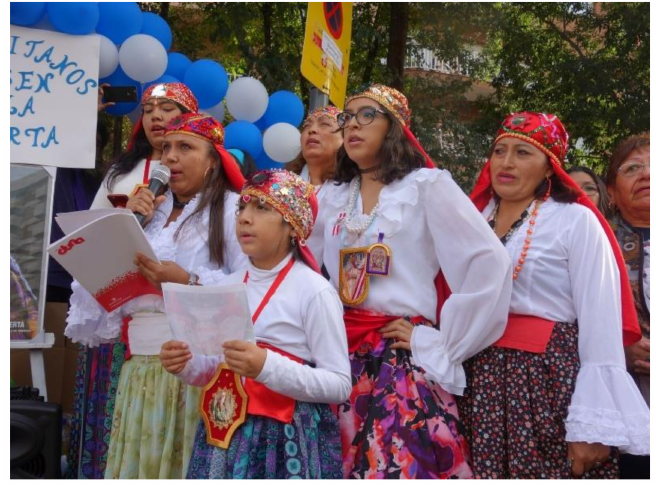
Figure 6. Dancers of the Association of Gypsies of the Virgen de la Puerta. October